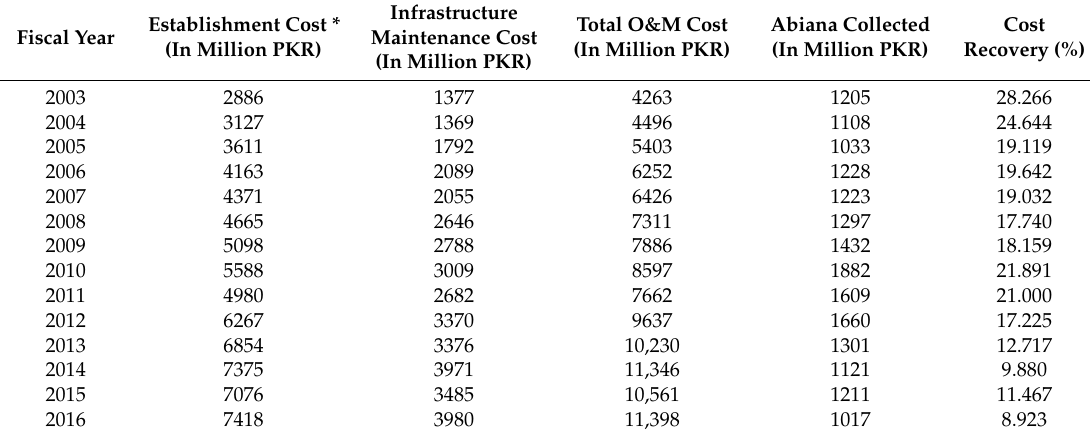
Table 4. O&M cost for the maintenance of Irrigation system in Punjab (Water share =